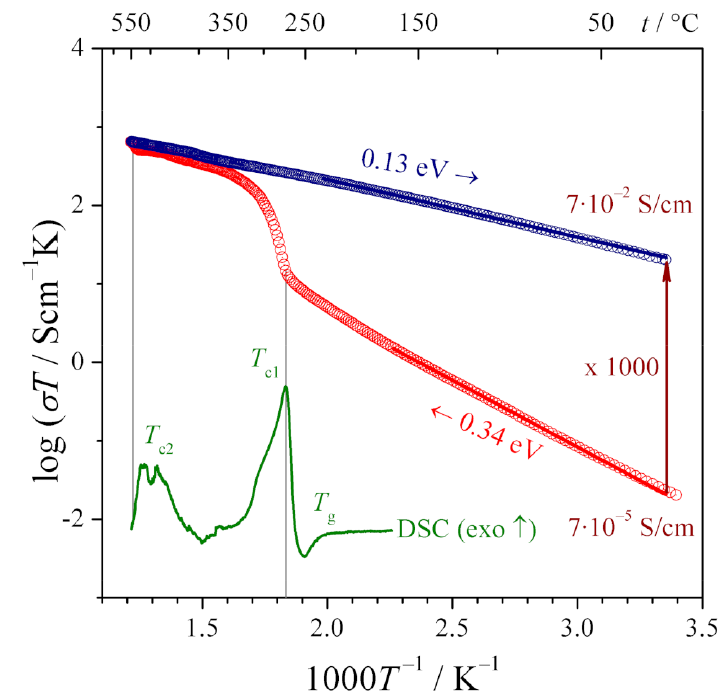
Figure 1. Temperature dependence of the electronic conductivity of a 90V 2 O 5 · 10P 2 O 5 glassy material upon heating to 550 ◦ C (1 ◦ C/min.) and cooling down to RT. The significant and irreversible increase in the conductivity is a result of nanocrystallization above T c . The inset shows a corresponding DSC trace (Reproduced with permission from ref. [34]. Copyright 2014, Elsevier).